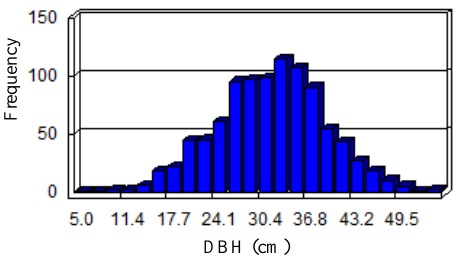
Figure 4. Histogram of DBH (cm) values